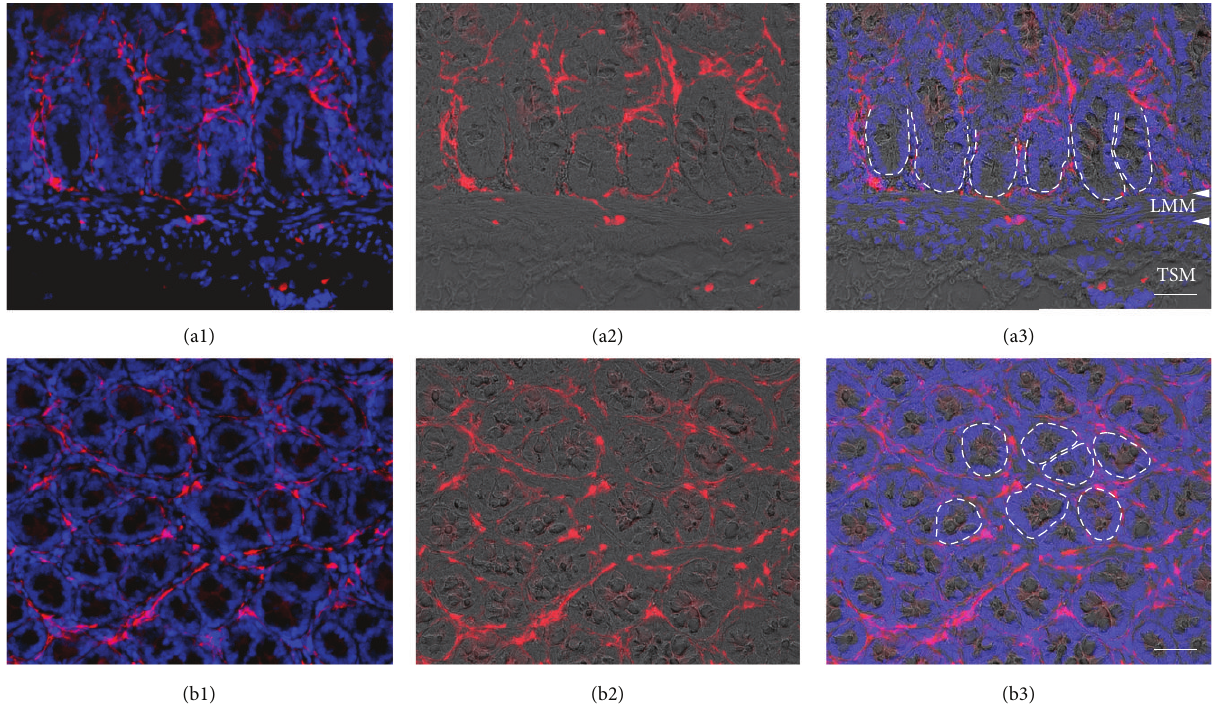
Figure 3: Epithelial crypts of the mucosa are surrounded by frizzled-4 positive neural extensions. Immunofluorescence of frizzled-4 (Fzd4) on cryostat sections of human ileum; (sample number 2). ((a1)–(a3)) Sagittal section. Combined Fzd4 (red) and DAPI (blue) fluorescence staining (a1); combined Fzd4 fluorescence (red) and brightfield view (a2); merge (a3). The broken lines mark the border between epithelial cells of the crypt base and the lamina propria mucosae. The white arrowheads indicate the borders of the lamina muscularis mucosae (LMM) to the lamina propria mucosae and the tela submucosa (TSM); scale bar: 50 𝜇 m. ((b1)–(b3)) Horizontal section of the crypt region. Combined Fzd4 (red) and DAPI (blue) fluorescence staining (b1); combined Fzd4 (red) fluorescence and brightfield view (b2); merge (b3). The broken lines mark the border between epithelial cells of some crypts and the lamina propria mucosae; scale bar (a, b): 50 𝜇 m.